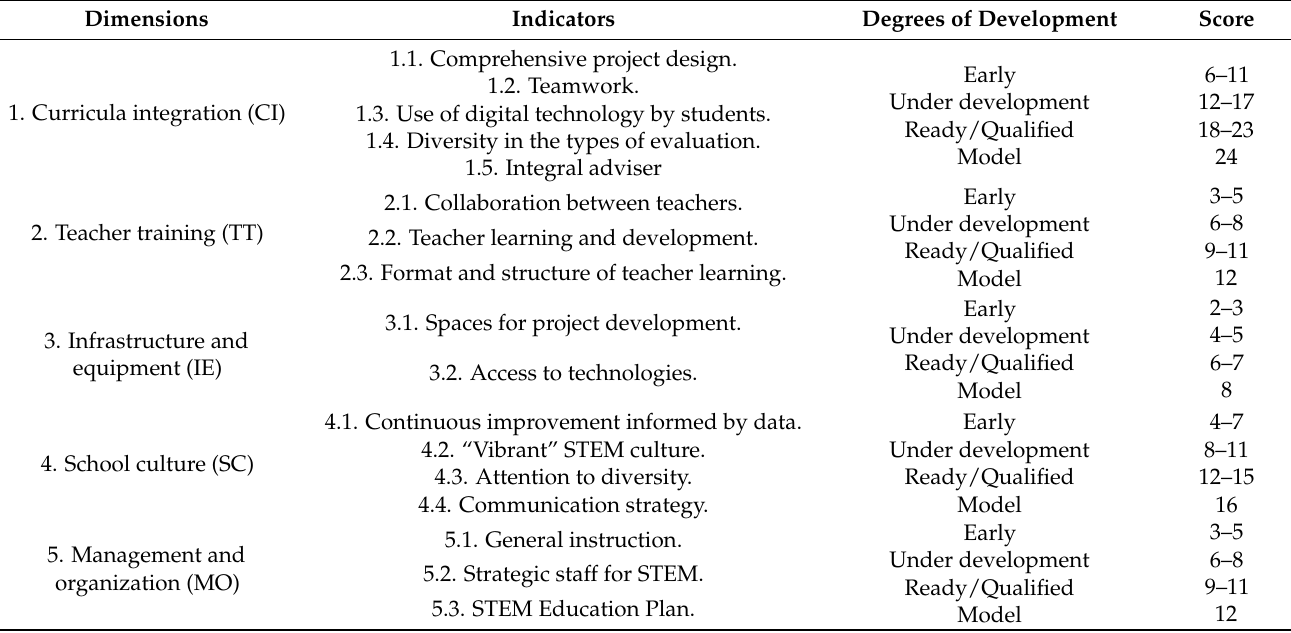
Table 1. Science, technology, engineering and mathematics (STEM) rubric dimensions: information about indicators, degrees of development and